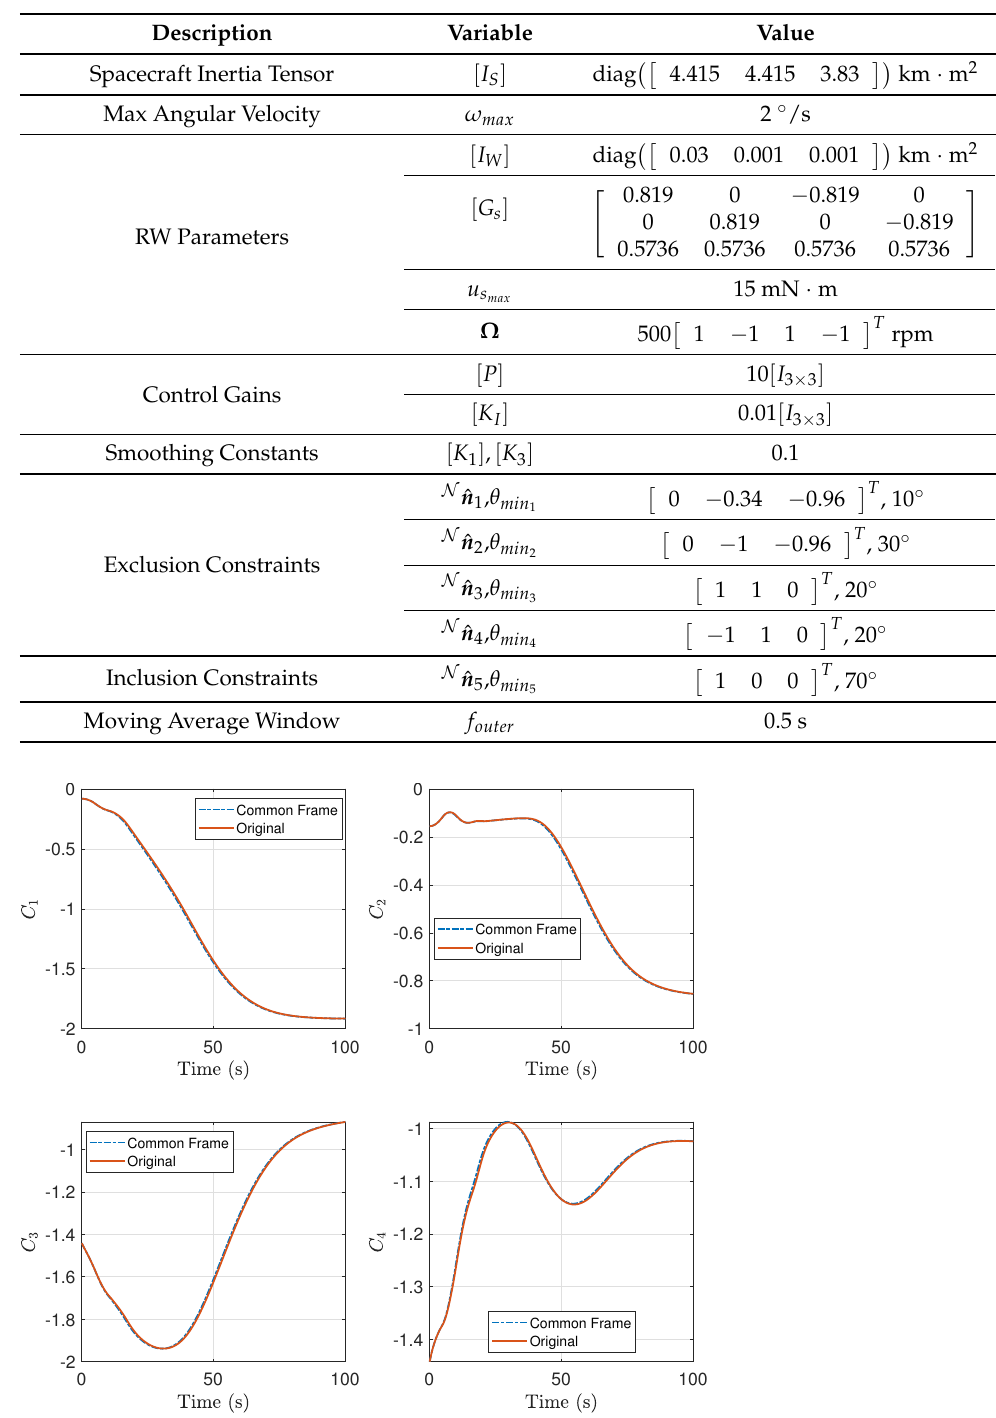
Table 2. Spacecraft and Pointing Constraint Parameters, Values obtained from [20] .